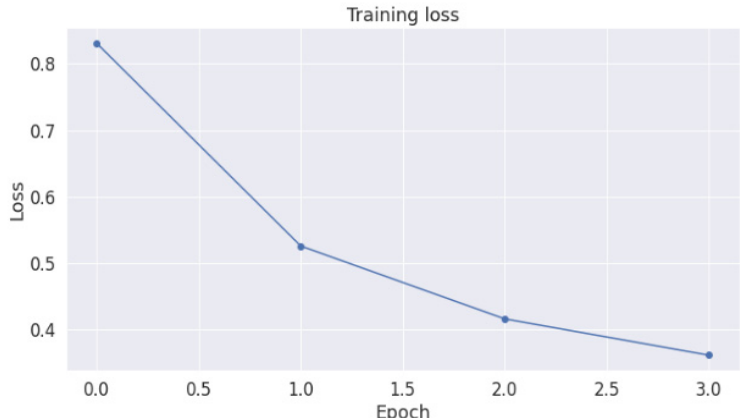
Figure 5. Training loss of our proposed CovBERT model.